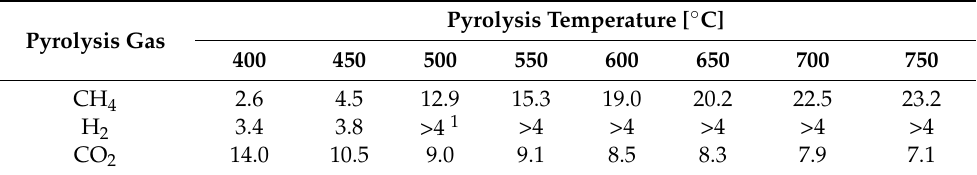
Table 4. Pyrolysis gas composition